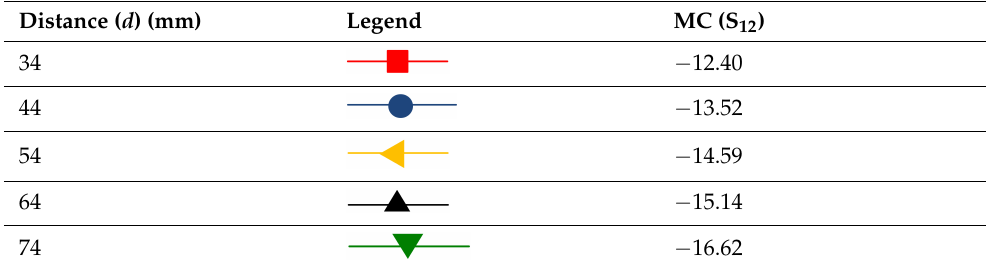
Figure 5. S–parameter of UWB MIMO antenna without EBG considering variations in d . Table 2. Variation of the MC with the far field distance for the MIMO UWB antenna arrays without